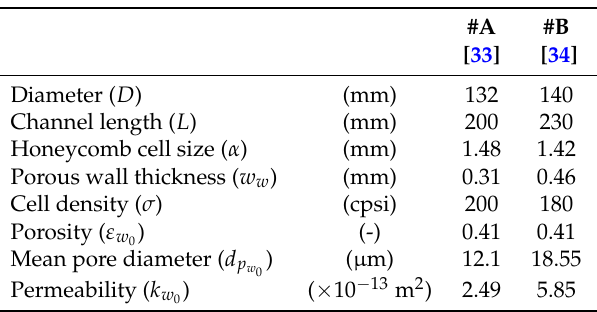
Table 1. Characteristics of wall-flow